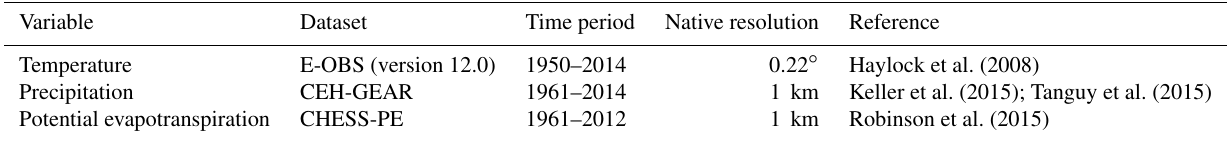
Table 1. Observational datasets. For the mean climate validation the common overlapping period 1961–2006 is used, while for precipitation extremes validation the overlap period between the historical baseline and CEH-GEAR (1900–2006) is used.